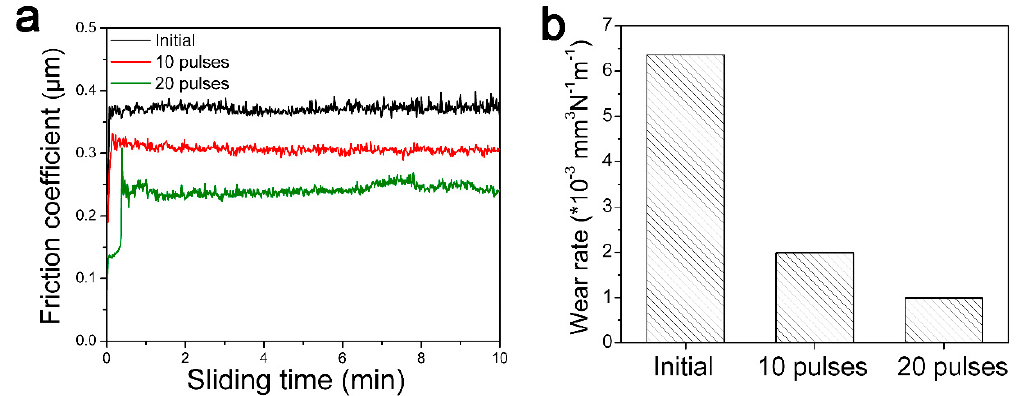
Figure 7. ( a ) The friction coefficient and ( b ) wear rate of the initial pure Ni and the HCPEB-irradiated of Cr–Ni sample surface. of Cr–Ni sample